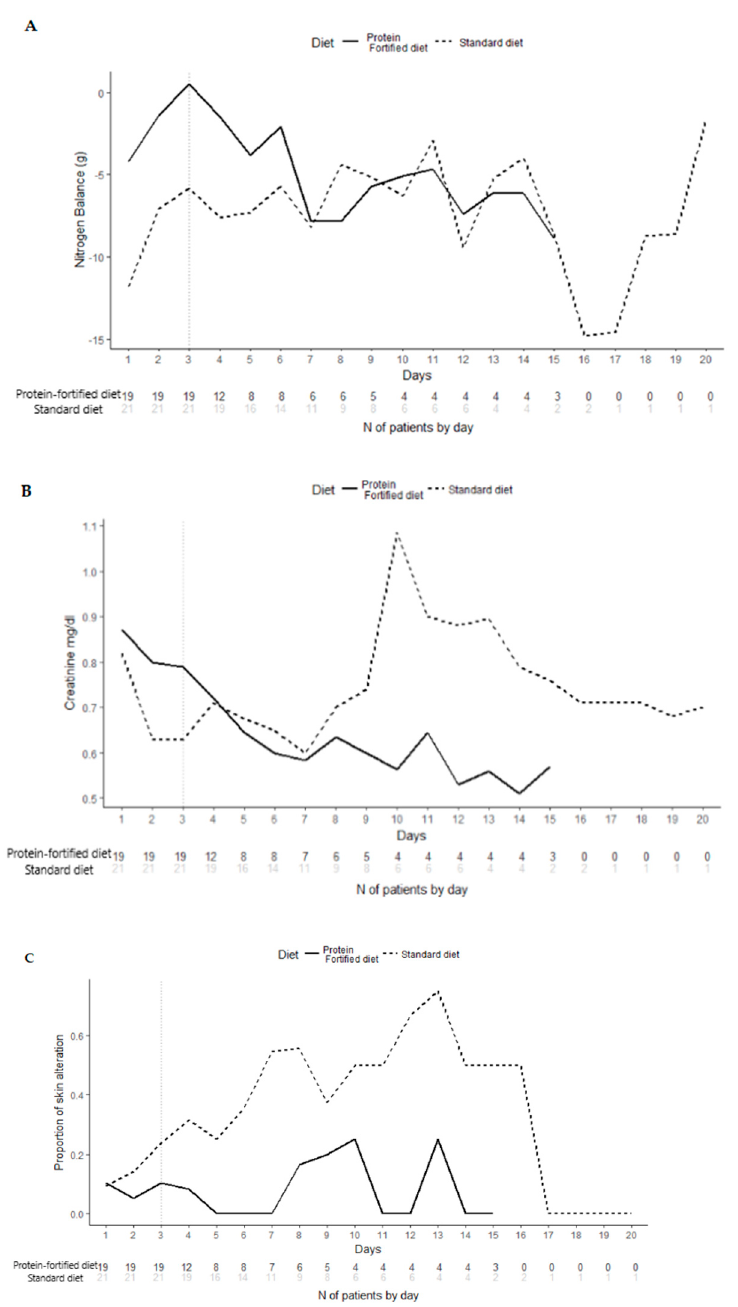
Figure 4. Longitudinal analysis of primary (A-nitrogen balance; p < 0.001. 3 Days E ff ect = 5.22 g 95% CI (3.86; 6.58)) and secondary (B-creatinine, p = 0.4011. 3 Days E ff ect = 0.22 mg / dL 95% CI ( − 0.17; 0.63); C-skin alteration, p = 0.1676. 3 Days Odd Ratio (OR) = 0.395 95% CI (0.12; 0.76)) endpoints. Curves are the descriptive analysis of the overall follow-up. The p -values indicate the significance of the di ff erences between treatment groups and have been adjusted by multiplicity for all secondary endpoints. The “3 Days E ff ect” refers to the model-based estimates of the di ff erences between the two diets evaluated at 3 days (in actual units).